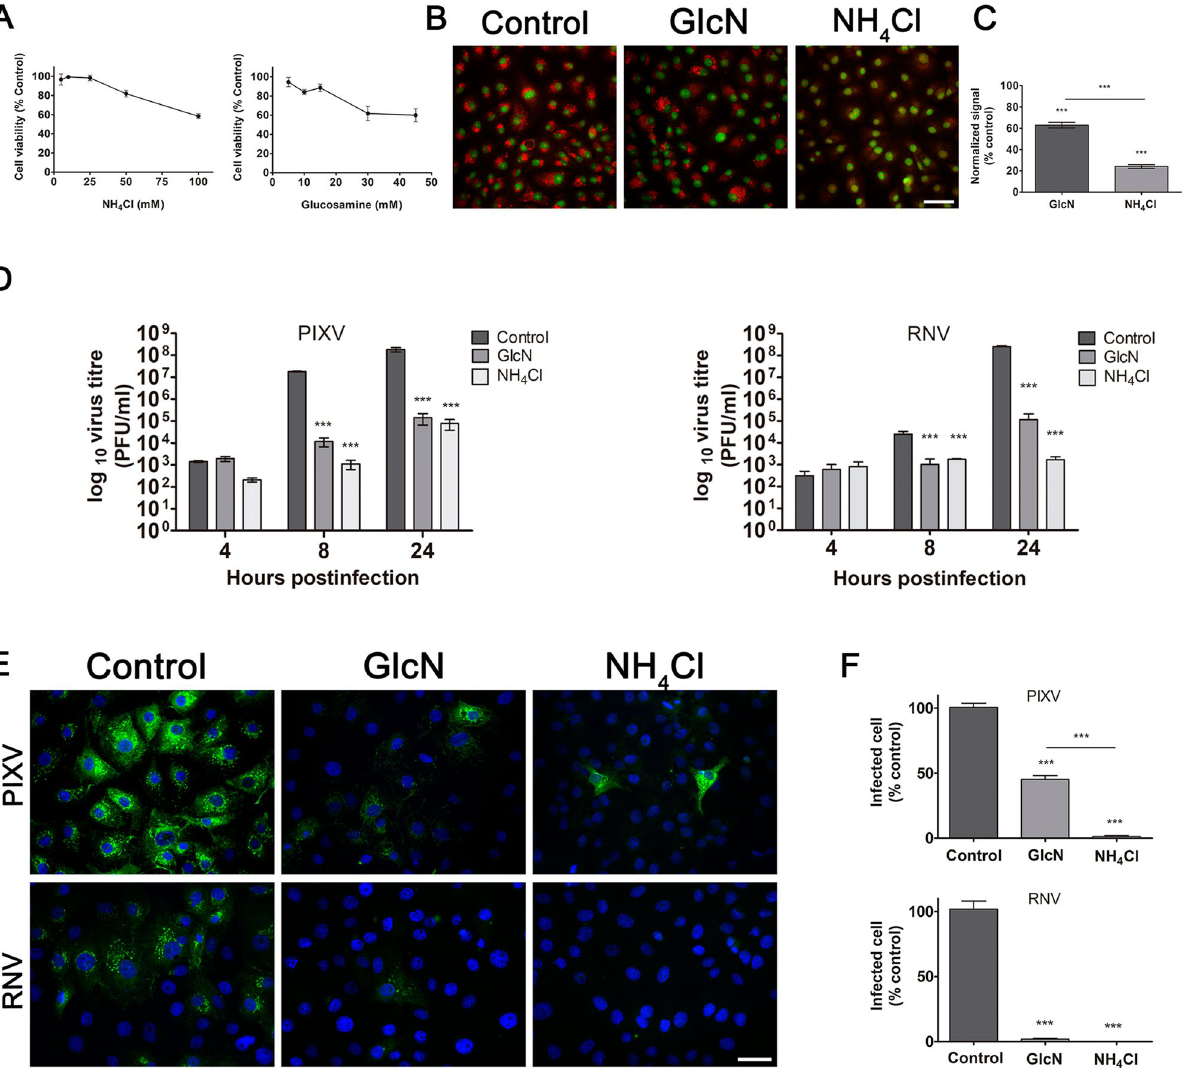
Figure 4. Effect of lysosomotropic agents on PIXV and RNV internalization. ( A ) MTT assay to determine GlcN and NH 4 Cl cytotoxic concentrations. ( B ) Representative images of Vero cells treated with 15 mM GlcN or 25 mM NH 4 Cl and incubated with acridine orange (red); nuclei (green) ( C ) Vero cells incubated with 15 mM GlcN or 25 mM NH 4 Cl and neutral red (NR). Percentages of inhibition were calculated by absorbance compared to control cultures. ( D ) Cells were pretreated with 15 mM GlcN or 25 mM NH 4 Cl and infected with PIXV or RNV at MOI 0.1 (green). Supernatants were collected at 4, 8 and 24 hpi and extracellular infectious particles were quantified by plaque assay (plaque-forming unit, PFU/ml). ( E ) Representative images of cultures treated with 15 mM GlcN or 25 mM NH 4 Cl and infected with PIXV or RNV (green) at MOI 10 and fixed at 8 hpi; nuclei (blue). ( F ) Percentage of infected cells with PIXV or RNV against controls (100% value). Data represent the mean ± SD from 3 independent experiments. Significance was calculated by one-way ANOVA test, followed by Tukey post-hoc analysis to enable specific group comparisons, with p value ≤ 0.05 considered as statistically significant. * p < 0.05; ** p < 0.01; *** p < 0.001. Scale bar: 20